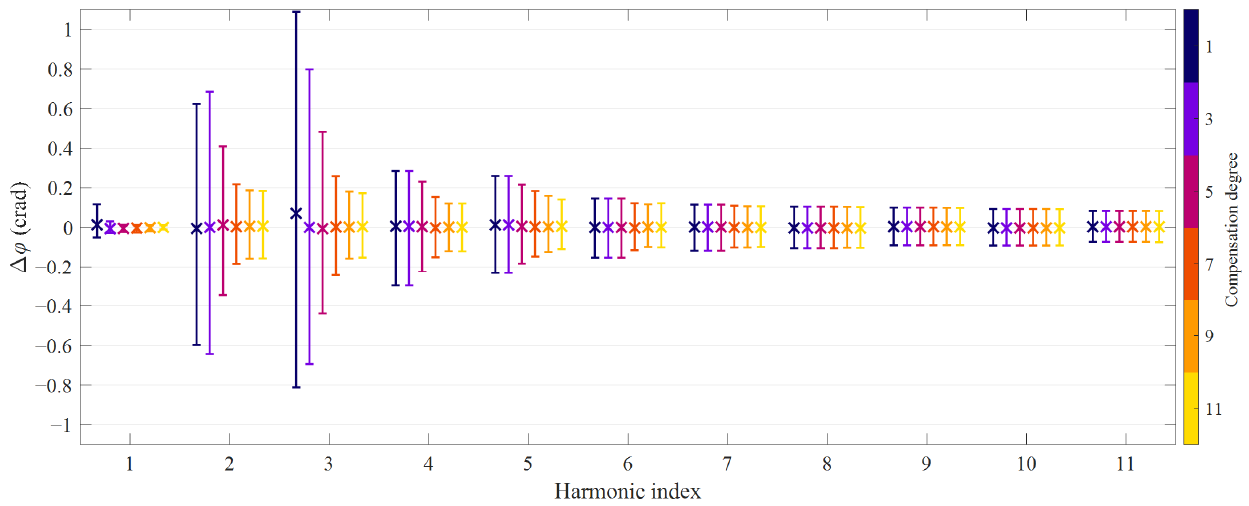
Figure 9. Phase displacement achieved with HD compensation degrees from 1 to 11: average values and 95th percentile bands; transformer CT1, class E 1 of primary current waveforms.